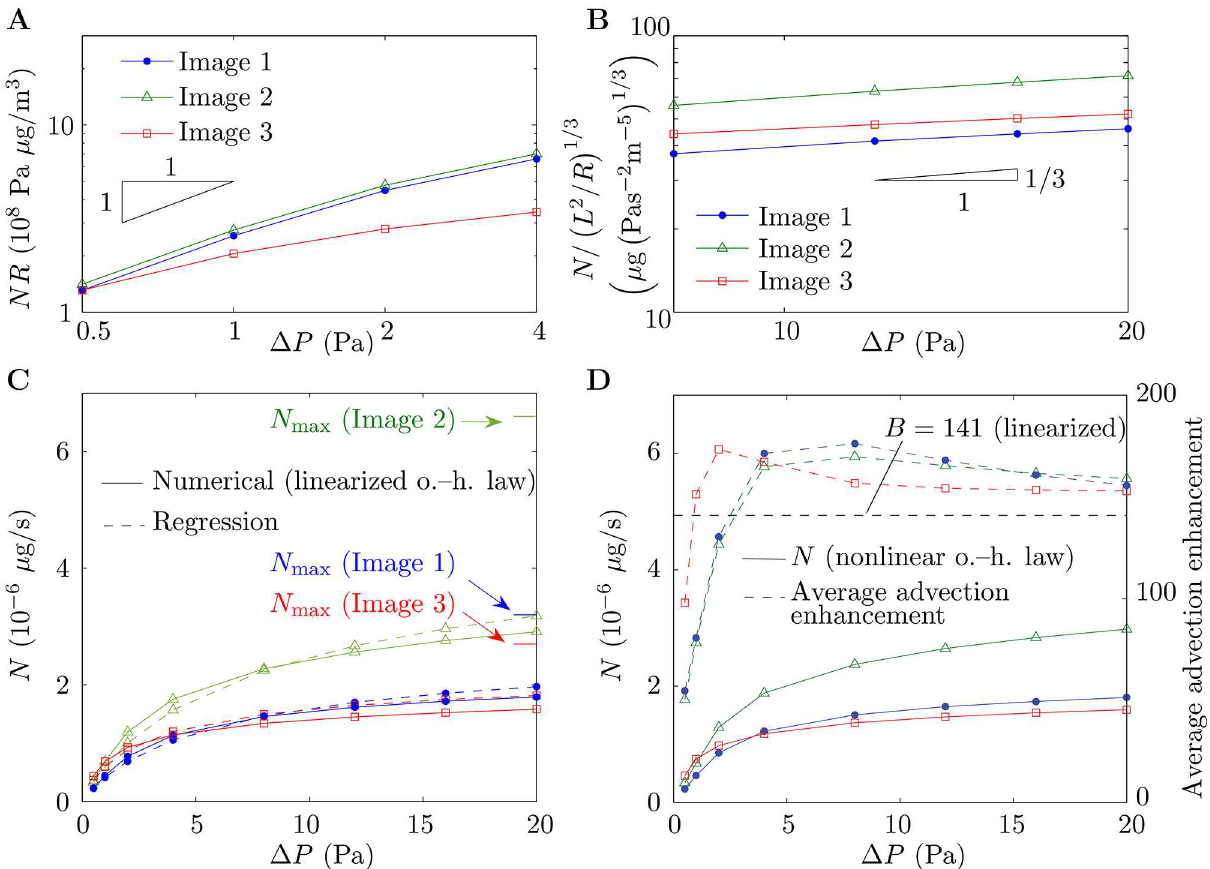
Fig 3. Scaling and regression. Throughout the figure, results for Image 1, Image 2 and Image 3 are denoted by blue dots, green triangles and red squares, respectively. (A,B) Scaled oxygen transfer rate (A) NR and (B) N /( L 2 / R ) 1/3 versus pressure drop Δ P , on log-log axes. Solid lines denote numericalresults and black triangles denote the gradients predicted by (A) scaling Eq (13) and (B) scaling Eq (12). (C) Oxygen transfer rate N versus Δ P with the linearizedoxygen–hemoglobindissociation law. Solid lines denote numericalresults and dashedlines denote results generated by the regression Eq (19). The upper bounds N max on N are indicated, which have been calculated by solving the diffusion equationin the surrounding villous volume with the capillary assumed to be deoxygenated. (D) Oxygen transfer rate N with the nonlinearoxygen–hemoglobindissociationlaw (solid lines) and average advection enhancement 1 þ ð c (dashed lines) versus Δ P . Also shown on the figure is the oxygen advection enhancement parameter B (black dashedline), derivedby linearizingthe oxygen–hemoglobindissociationlaw.